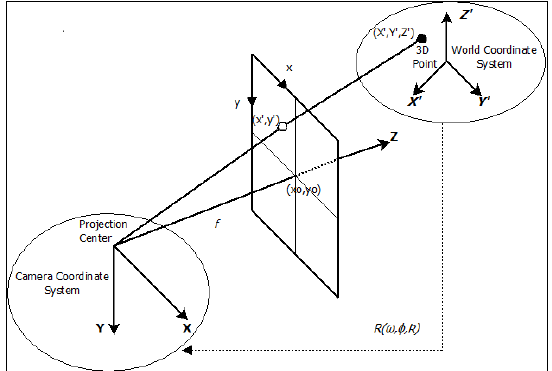
Figure 2. Projection of 3D laser point onto a plane defined in camera coordinate